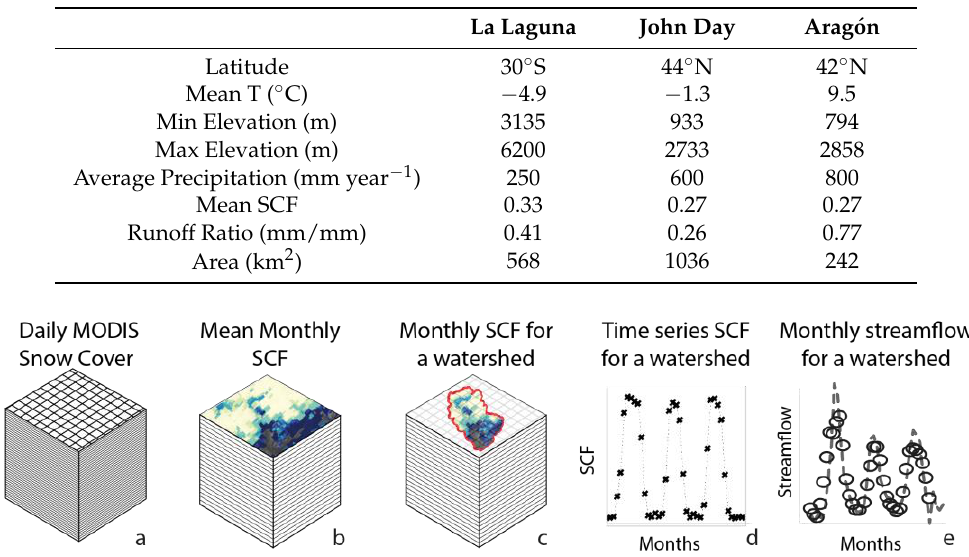
Table 1. The topographic and climatic characteristics of the three study watersheds. Mean temperature (T) and Snow Cover Frequency (SCF) corresponds to the four primary winter months (May–September in the southern hemisphere, and November–March in the northern hemisphere).